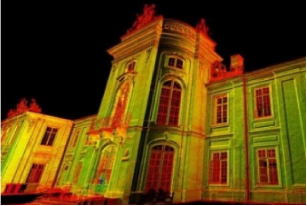
Figure 2. 3D point cloud data produced by laser scanner (Source: http://www.3deling.com/category/3d-laser-scanning/)